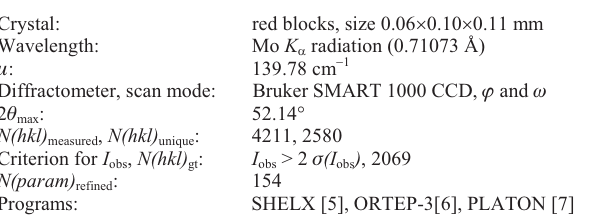
Table 1. Data collection and handling.